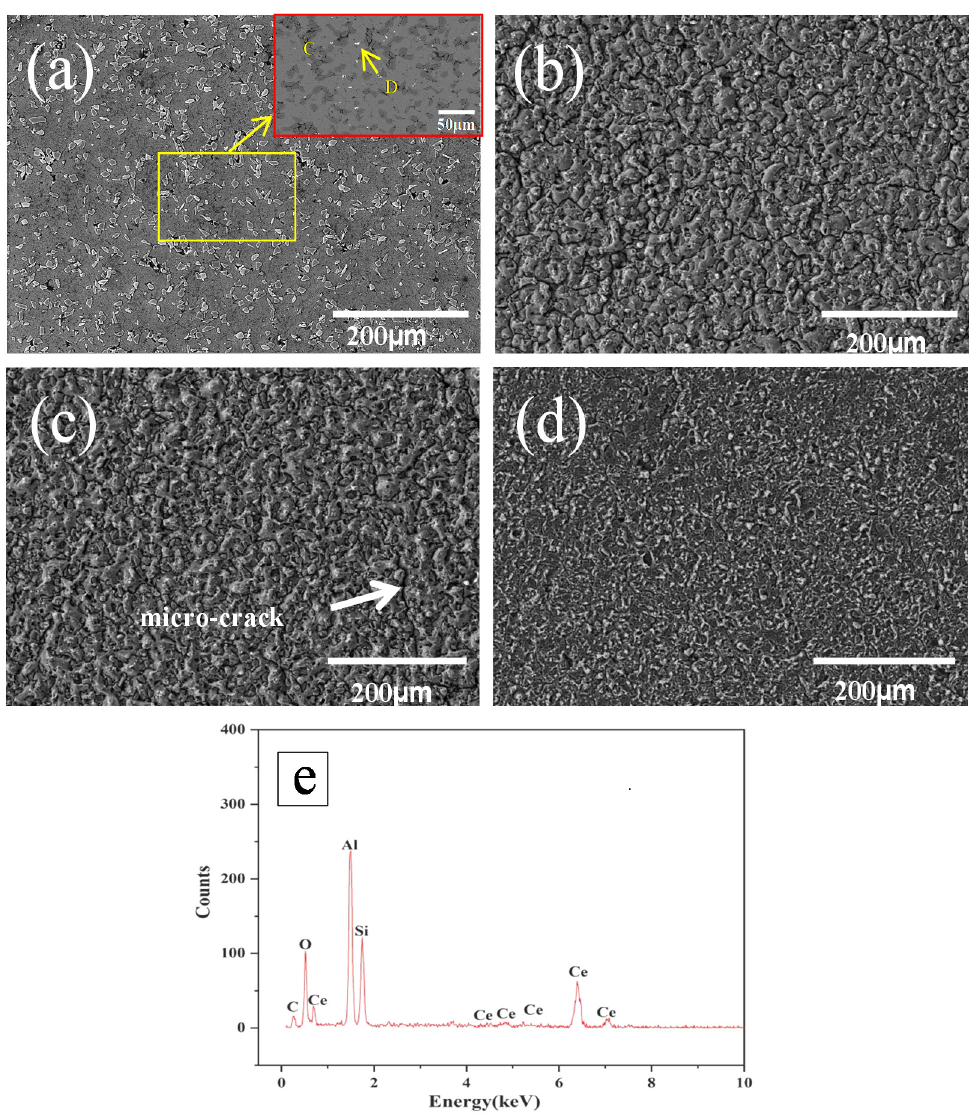
Figure 3. Surface SEM images of Al-20SiC-0.3CeO 2 sample before and after HCPEB irradiation: ( a ) initial, ( b ) 5 pulses, ( c ) 15 pulses, ( d ) 25 pulses, and ( e ) EDS results of the B point in Figure